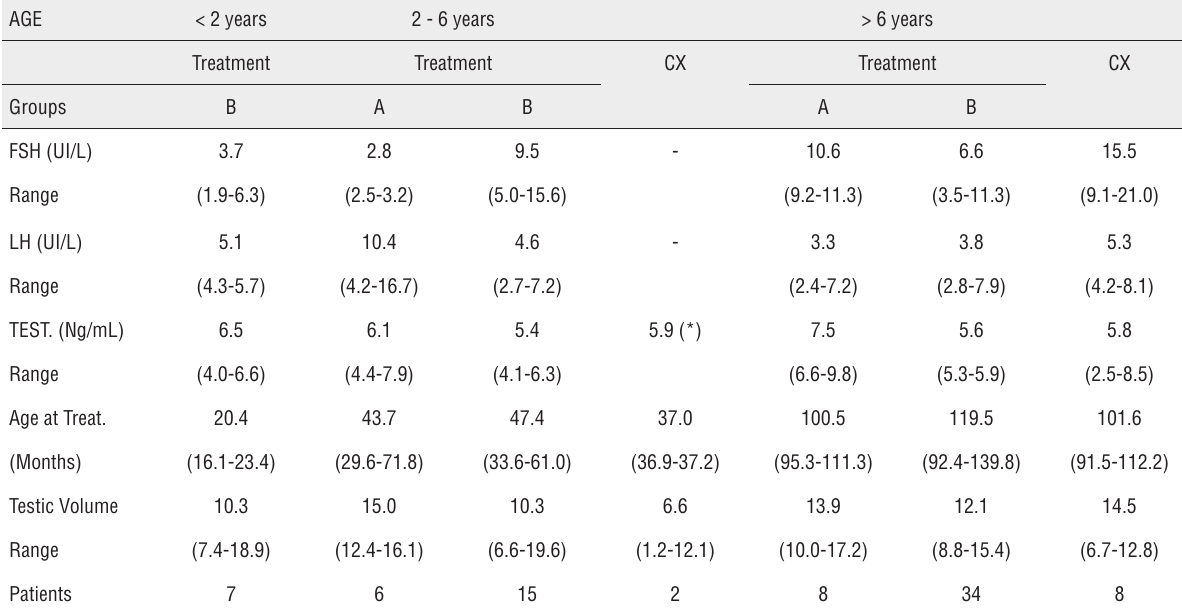
Table 4 - Bilateral cryptorchidism (n=80) Features based on age and therapy (A-only hormonal treatment; B-hormonal first and surgery later; CX – surgery alone; TEST-